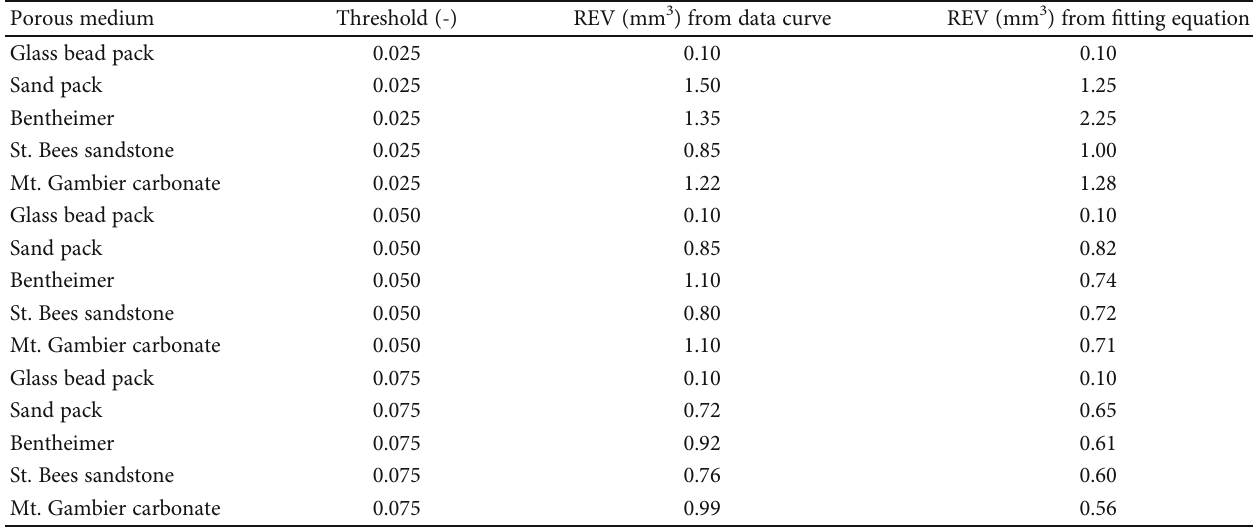
analysis. Associated equations are shown in Table 8 and associated data in Figure 8. g